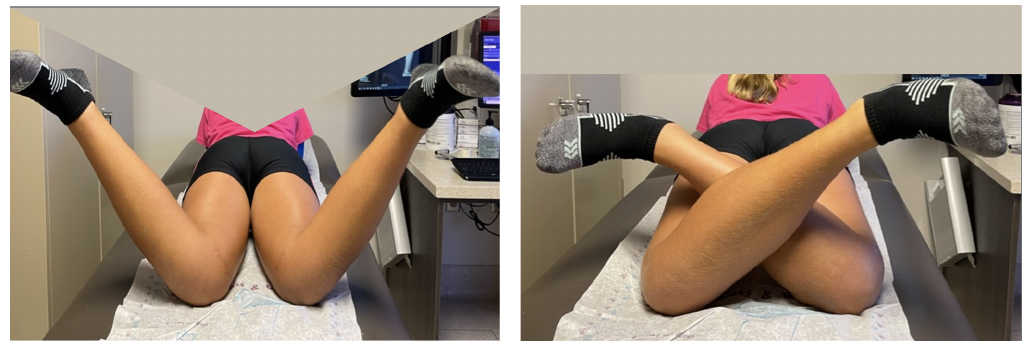
Figure 5. Postoperative internal ( left ) and external ( right ) rotation of both hips after rotationally guided growth correction. Compare this to the preoperative photos of the same patient in Figure 1 (Patient